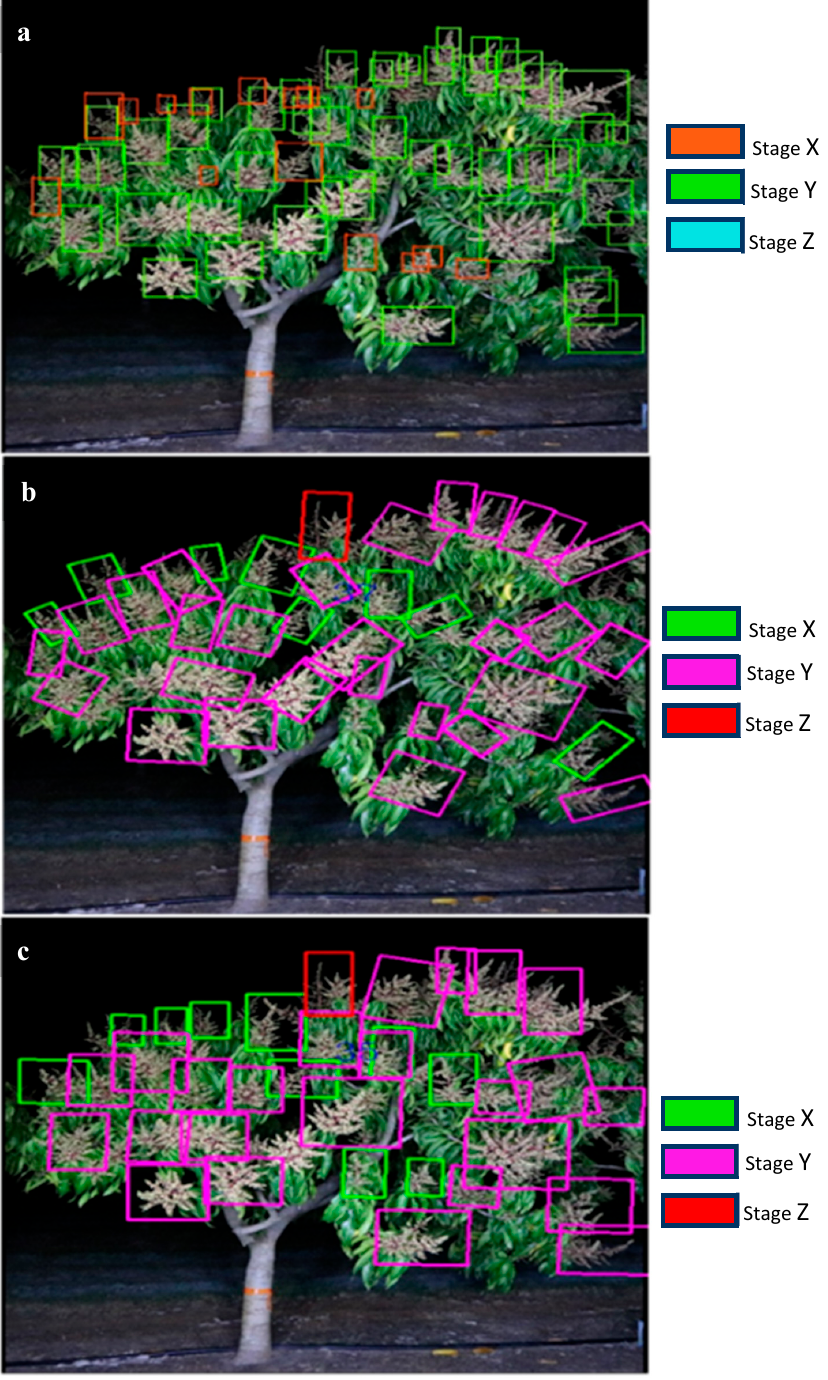
Figure 6. Images of panicle stage detection on Canon images of [21]. ( a ) MangoYOLO(-upright) method: orange, green and blue coloured boxes represent panicle stages X, Y and Z respectively. ( b ) R 2 CNN(-rotated) and ( c ) R 2 CNN-upright methods, respectively: green, pink and red coloured boxes represent panicle classes of X, Y and Z, respectively.